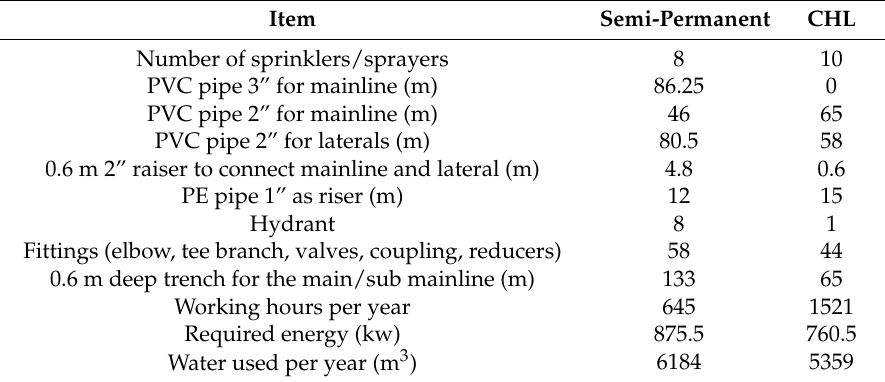
Table 2. Semi-permanent and CHL system components comparison.